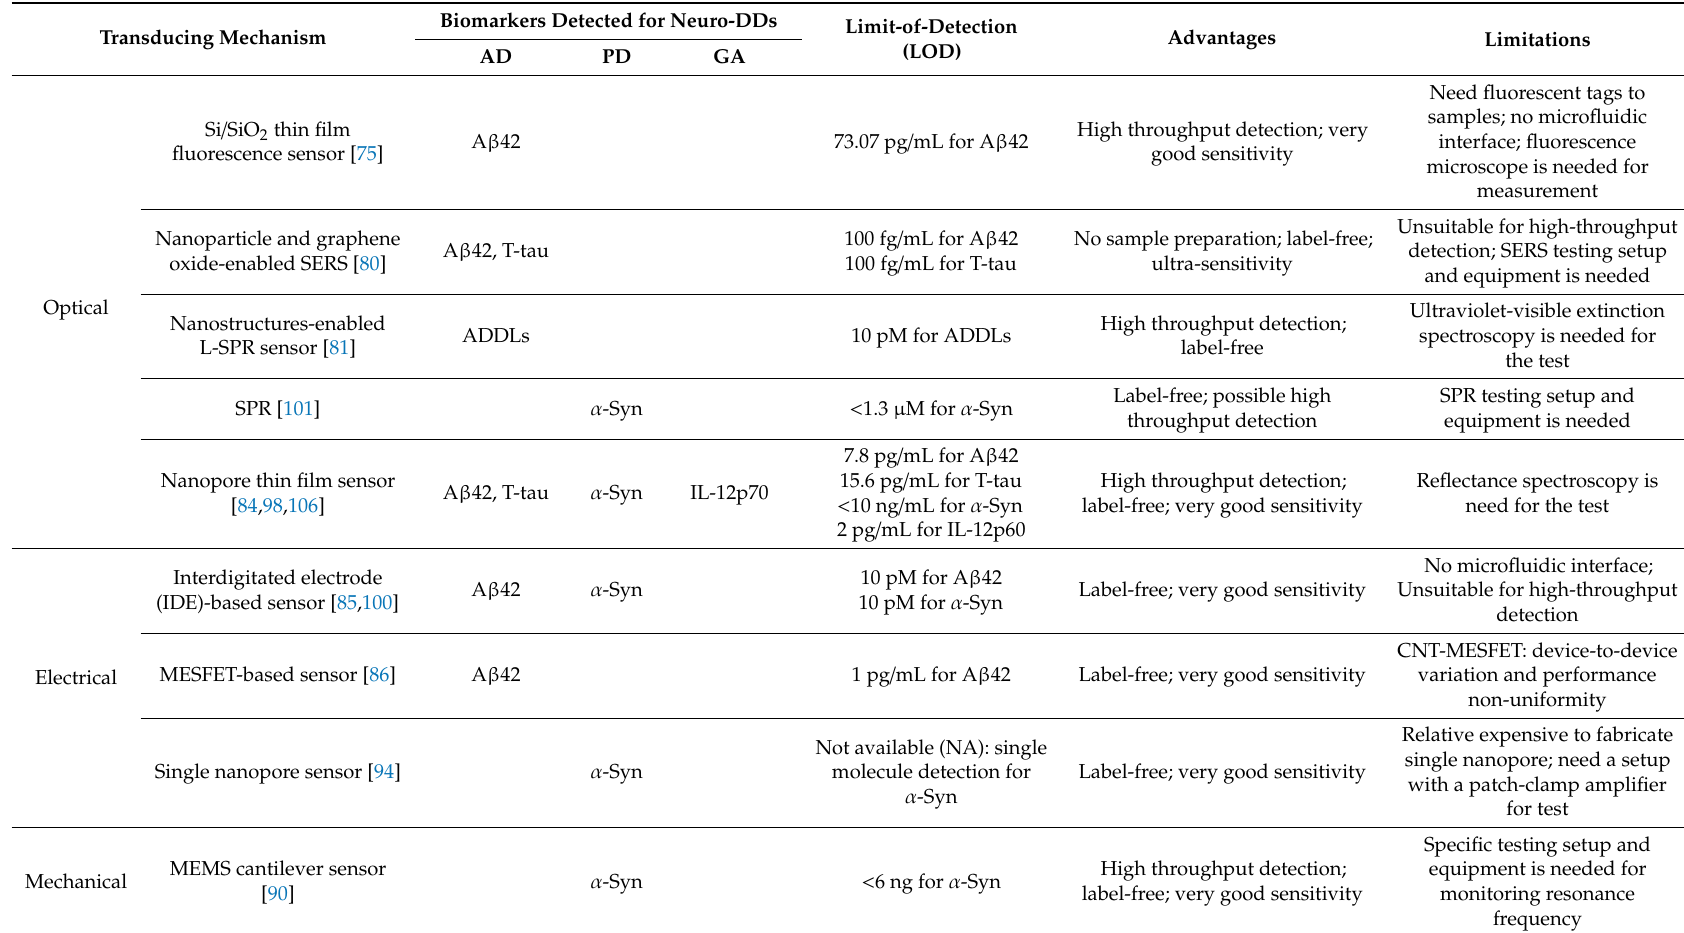
Table 1. Summary of the chip-based sensing for detecting biomarkers of neurodegenerative diseases